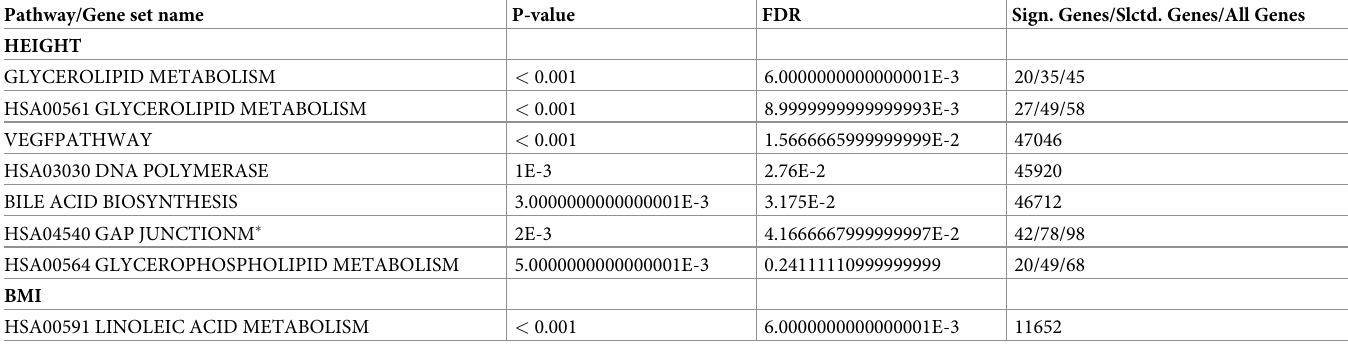
Table 2. Enriched canonical pathways for height and BMI sibling-pair standard deviations in FHS, estimated using